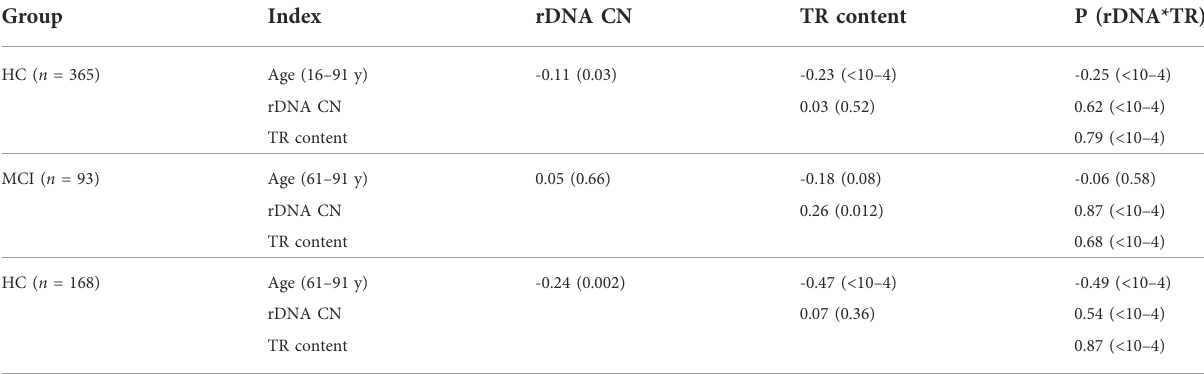
TABLE 3 Spearman ’ s rank correlations [Rs (p)] between the analyzed parameters in the HC and MCI groups.